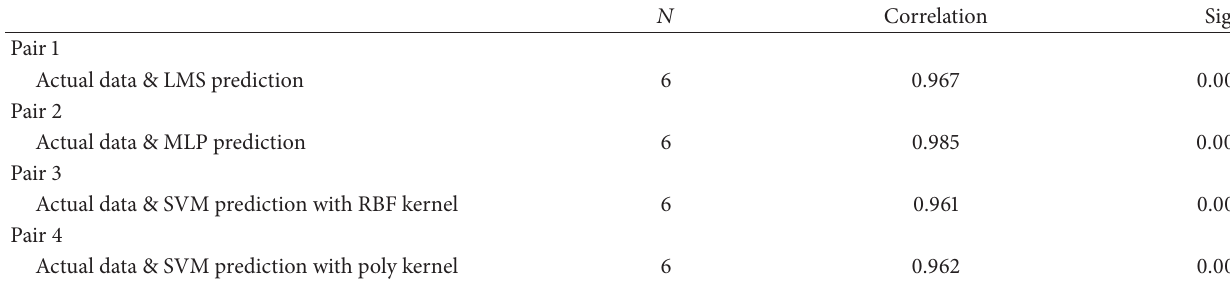
Table 8: Paired samples